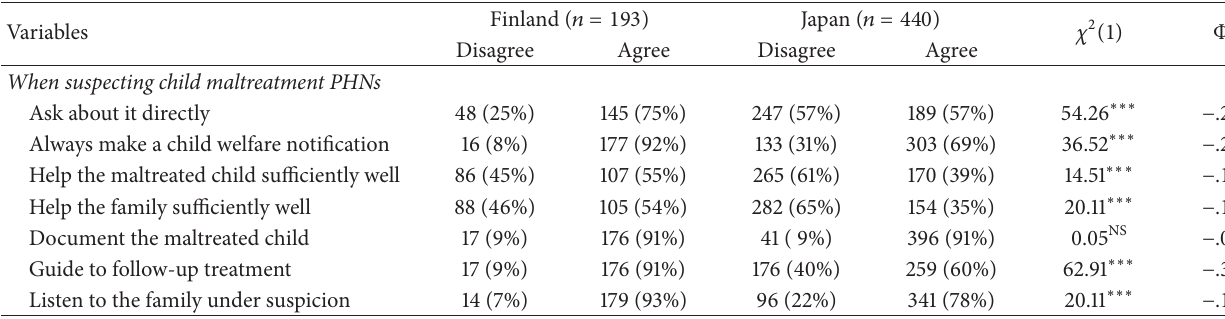
Table 4: Intervention when suspecting child